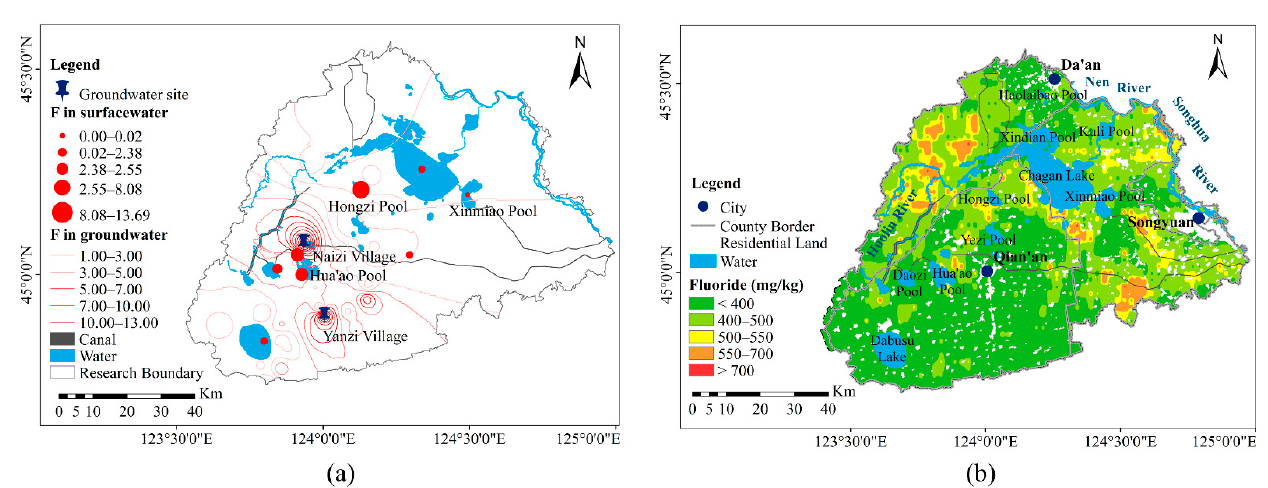
Figure 4. ( a ) Distribution characteristics of F – concentration in water; ( b ) distribution characteristics of total fluoride in soil.